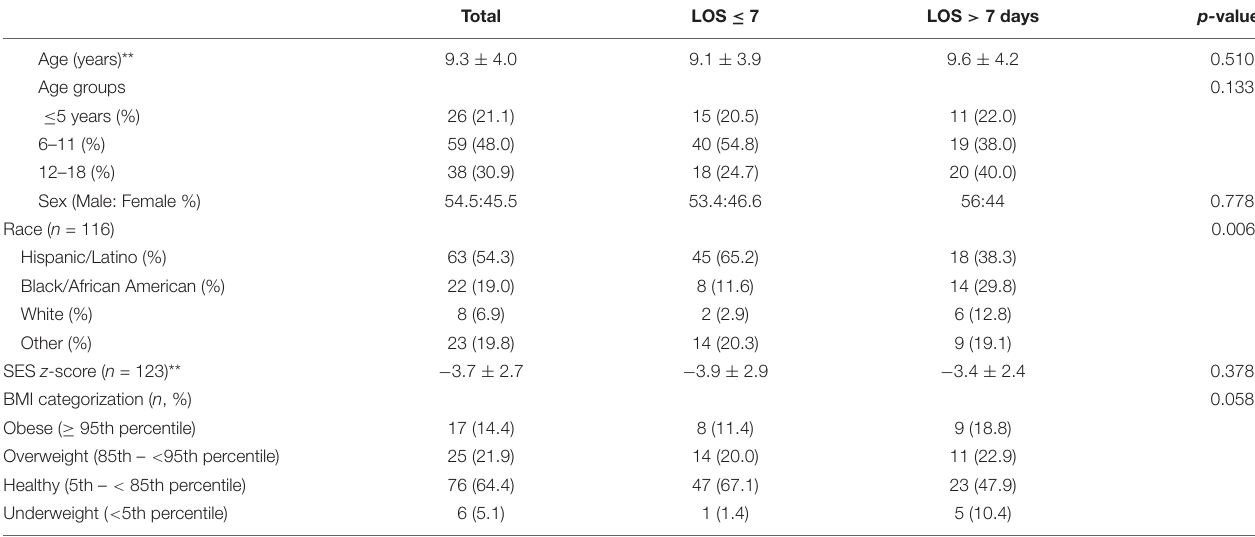
TABLE 1 | Demographics of cohort by dichotomized length of hospitalization (LOS).